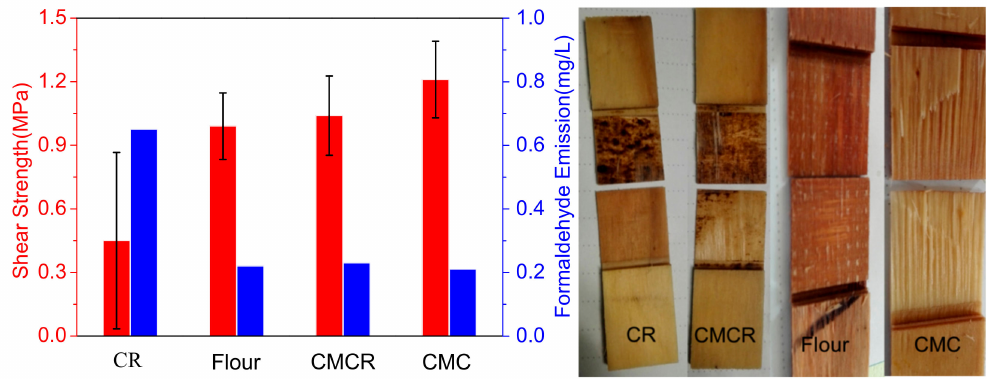
Figure 9. ( A ) Shear strength and formaldehyde emission of plywood; and ( B ) adhesive failure